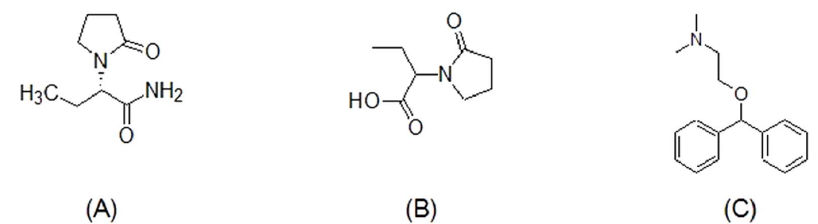
Figure 1. Molecular structures of (A) Levetiracetam (molecular weight 170.2), (B) Etiracetam carboxylic acid (molecular weight 171.2) and (C) Diphenhydramine (molecular weight 255.4).